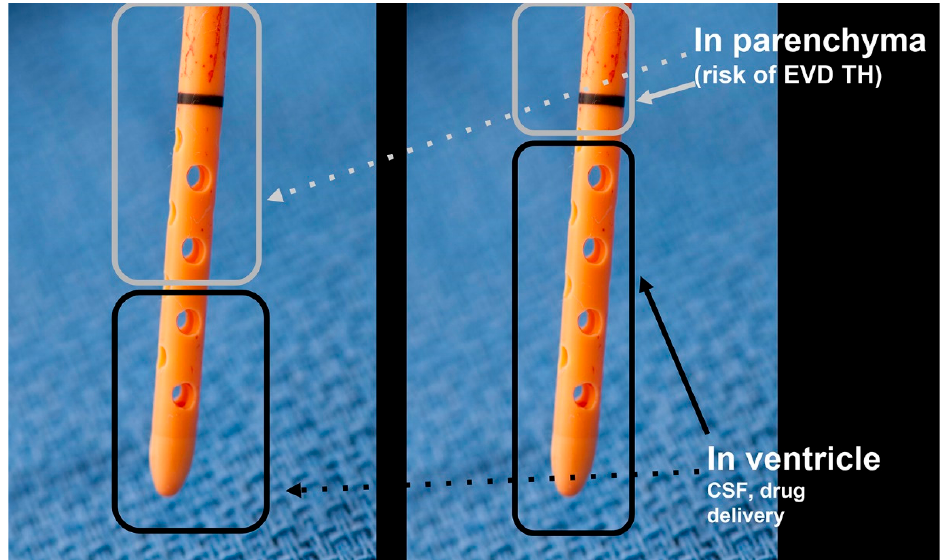
Figure 2. An explanted external ventricular drain (EVD) visually demonstrates the rationale for intraventricular nicardipine delivery and how the EVD (ventricle/parenchyma) fenestration ratio can help guide intrathecal drug injection safety. EVD fenestrations can be seen on computed tomography bone windows when using large bore 1.9 mm inner diameter EVD catheters, such as those used in this